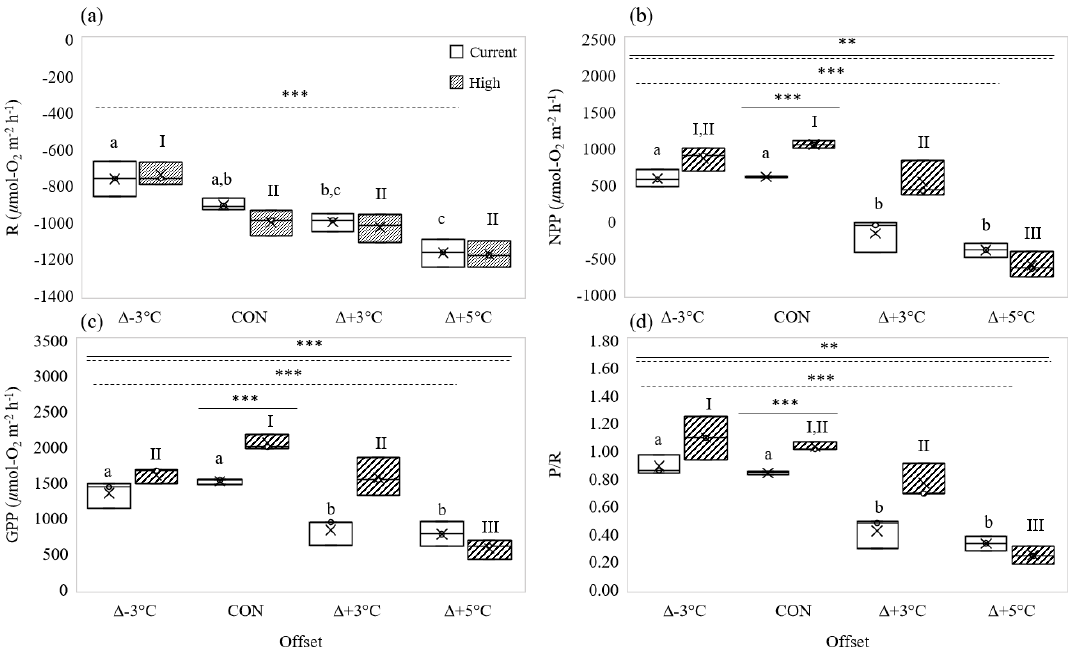
Figure 2. Effect of temperature on rates of (a) respiration ( R , µmolO 2 m − 2 h − 1 ), (b) net primary production (NPP, µmolO 2 m − 2 h − 1 ), (c) gross primary production (GPP, µmolO 2 m − 2 h − 1 ) , and (d) P /R under current (open boxes) and high- p CO 2 conditions (hatched boxes). Panels show mean values “ × ” at three temperature offsets from control (CON = 23 ◦ C). Middle horizontal line in each box is the exclusive median, with the start of the upper and lower quartiles represented by the top and bottom edges of the box, respectively. Letters identify significantly different means across temperatures under current p CO 2 conditions, and numerals identify significantly different means across temperatures under high- p CO 2 conditions, where letters or numerals that are the same indicate no significant difference, as determined by post hoc Tukey’s test. Solid and dashed horizontal lines identify significant effects of OA and temperature, respectively, where double solid and dashed lines identify significant interaction of temperature and OA (two-way ANOVA). Levels of significance are denoted with “ ∗ ” for 0.05, “ ∗∗ ” for 0.01, and “ ∗∗∗ ” for 0.001. Data in Tables S3 and S4.